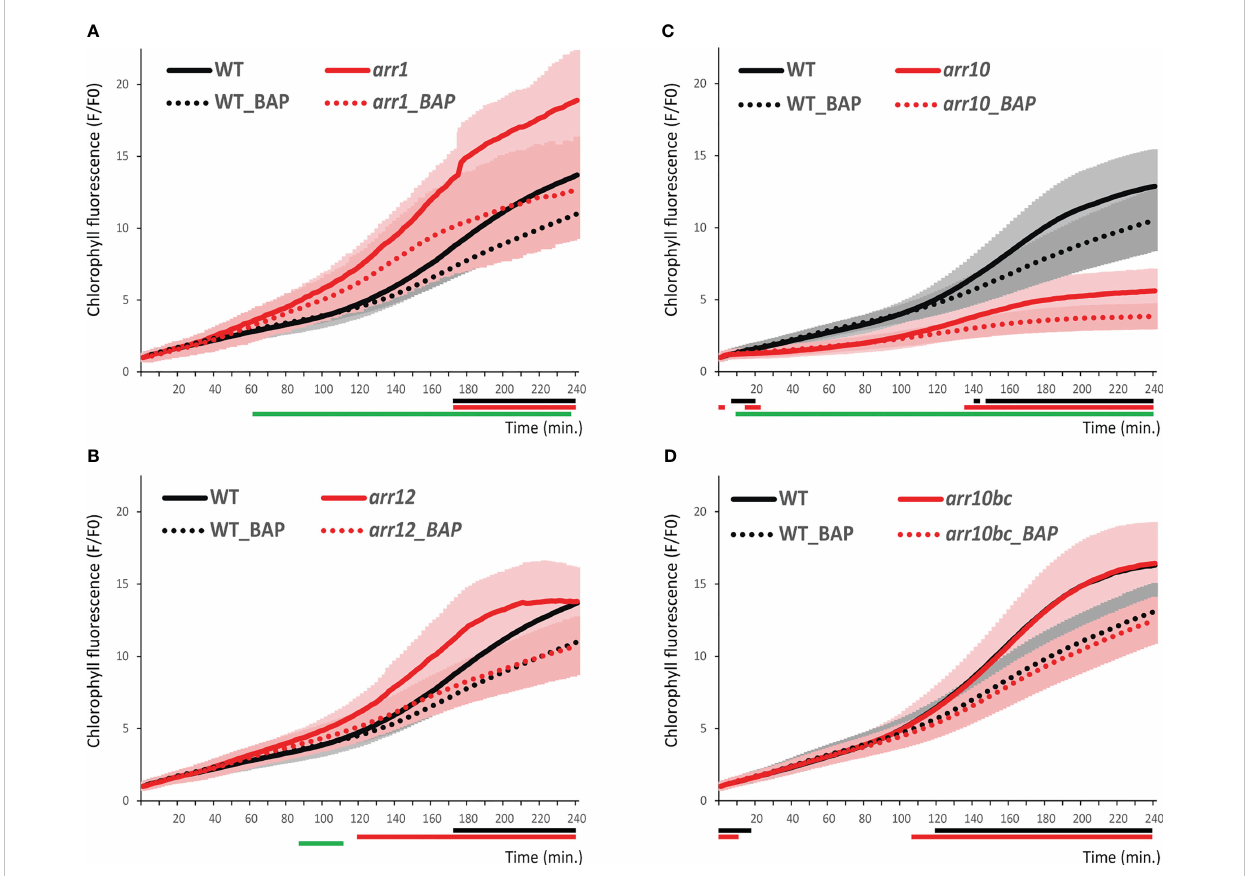
FIGURE 5 Chlorophyll kinetics in wild-type and type-B ARR mutants. Chlorophyll accumulation in WT Col-0 and arr1 (A) , arr12 (B) , arr10 (C) , and arr10 backcrossed ( arr10bc , (D) mutant lines. Data represent the mean values ± SD, n=9 of raw data ( fl uorescence F) normalized to the mean fl uorescence value at T0 (F0). Lines under the x axis (black for WT and red for mutant) indicate the time intervals with signi fi cantly different values in pairwise comparison between the non-treated and BAP-treated seedlings of a given genotype. The green lines under the x axis depict the signi fi cantly different values (P<0.05) the corresponding time intervals between mock-treated WT and mutant